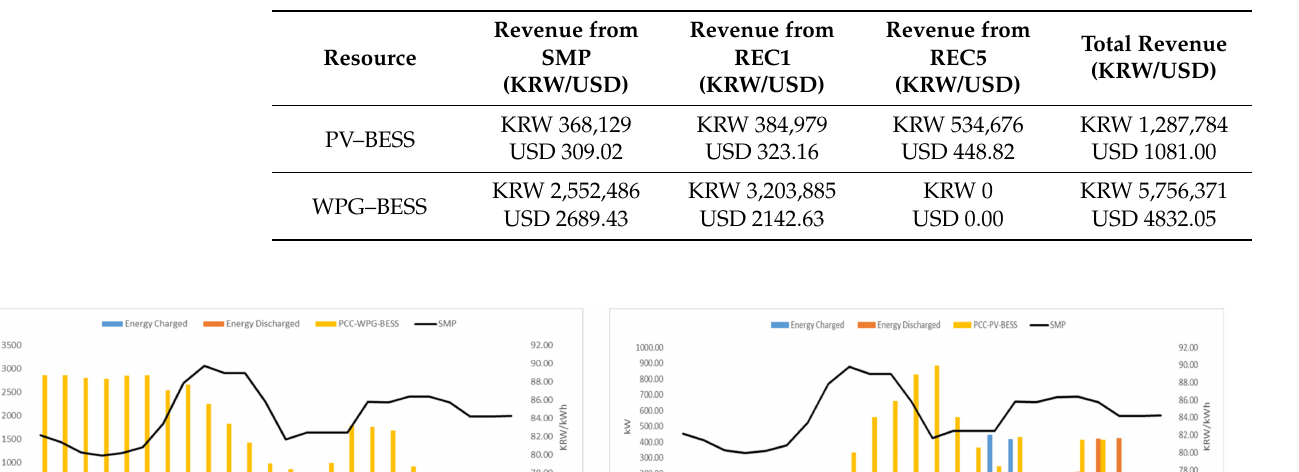
Table 8. Intraday revenue generated from the prior operating method.